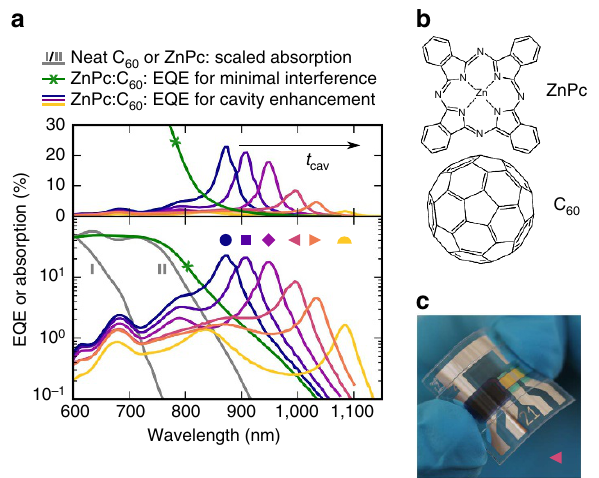
Figure 2 | NIR detectors based on ZnPc:C 60 CTabsorption. ( a ) Spectrally resolved EQE or absorption on linear (top) or logarithmic (bottom) scale. The green, crossed line indicates the EQE of a ZnPc:C 60 solar cell with minimal optical cavity effect. The grey lines are scaled to the previous curve and represent the absorption of neat C 60 (marked as I) or ZnPc (marked as II). The remaining curves show the EQE of several cavity-enhanced ZnPc:C 60 detectors, measured at short circuit. Tuning the cavity thickness t cav via a simultaneous thickness variation of both transport layers allows shifting the resonance wavelength. Both samples marked as triangles are mechanically flexible, while the remaining are encapsulated with glass. ( b ) Chemical structures of the blend constituents. ( c ) Photograph of a flexible device, marked as b in a . The left half of the photo-active area features a sequence of neat absorbers to suppress the photo-response from visible light.